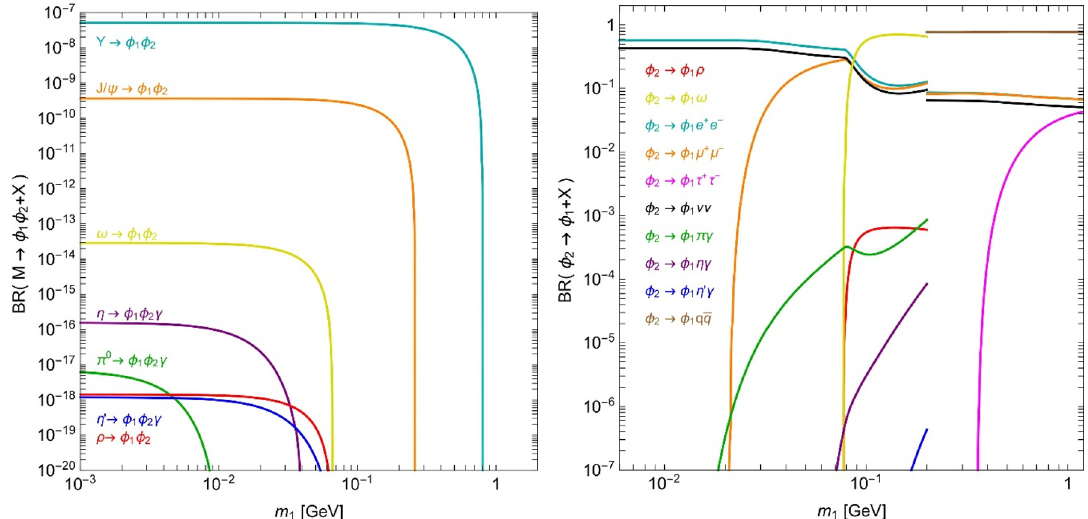
Figure 1 . Left panel: branching ratio of meson decays into dark states. Right panel: branching ratio of φ 2 decays into φ 1 and SM states. In both panels we take c f Λ = 1 TeV. In the right panel the threshold at m 1 ’ 0.2 GeV denotes the transition of the treatment of φ 2 hadronic decays from chiral perturbation theory to perturbative QCD. See appendix A for